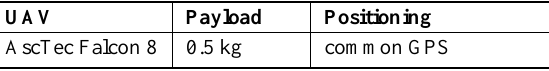
Table 1: Overview of micro-sized